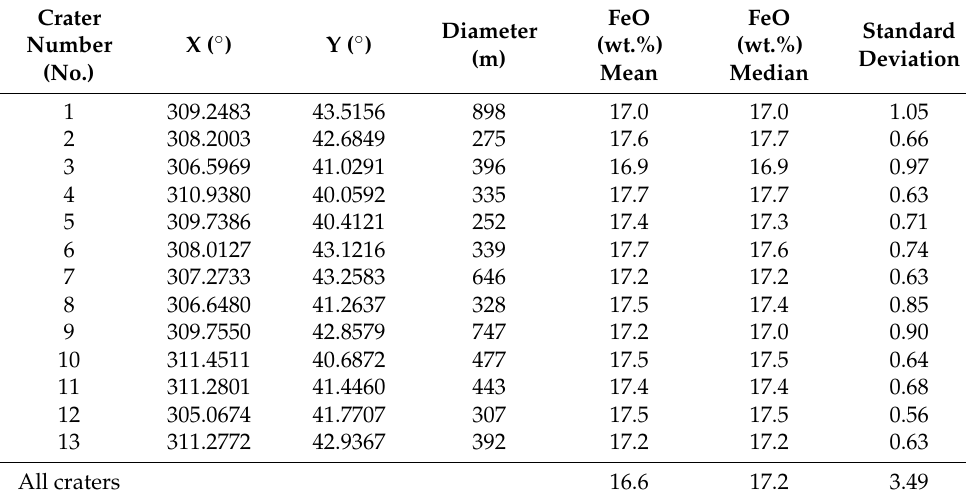
Figure 4. FeO ( a ) and TiO 2 ( b ) classification map. ( c ) and ( d ) show the relative frequencies of FeO and TiO 2 contents, respectively. Table 1. Properties of the identified fresh craters in the Em4